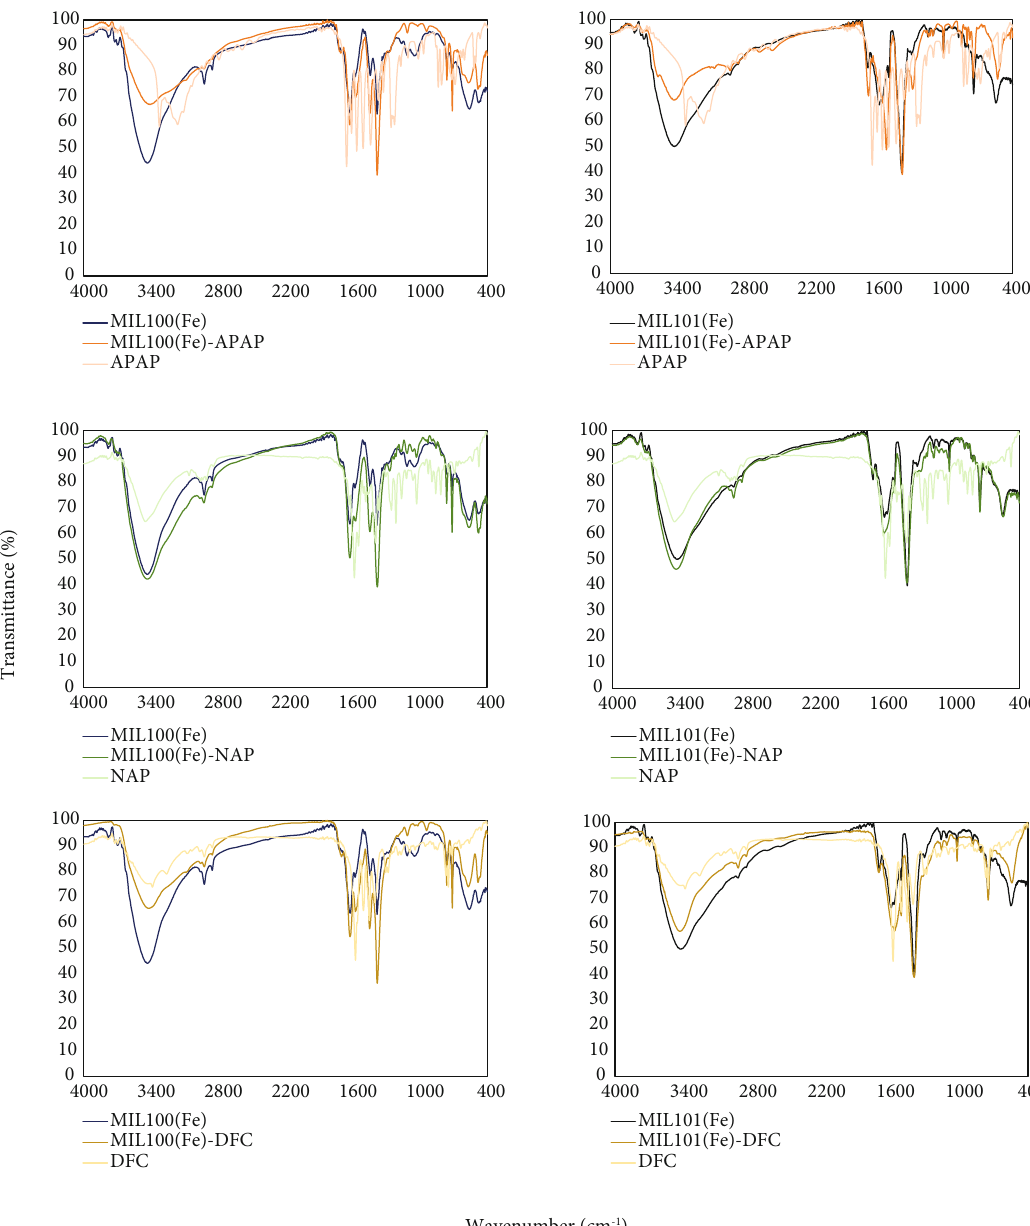
Figure 2: FTIR spectra of (a) MIL-100-Fe and (b) MIL-101-Fe before and after the adsorption of naproxen (NAP), diclofenac (DFC), and acetaminophen (APAP)